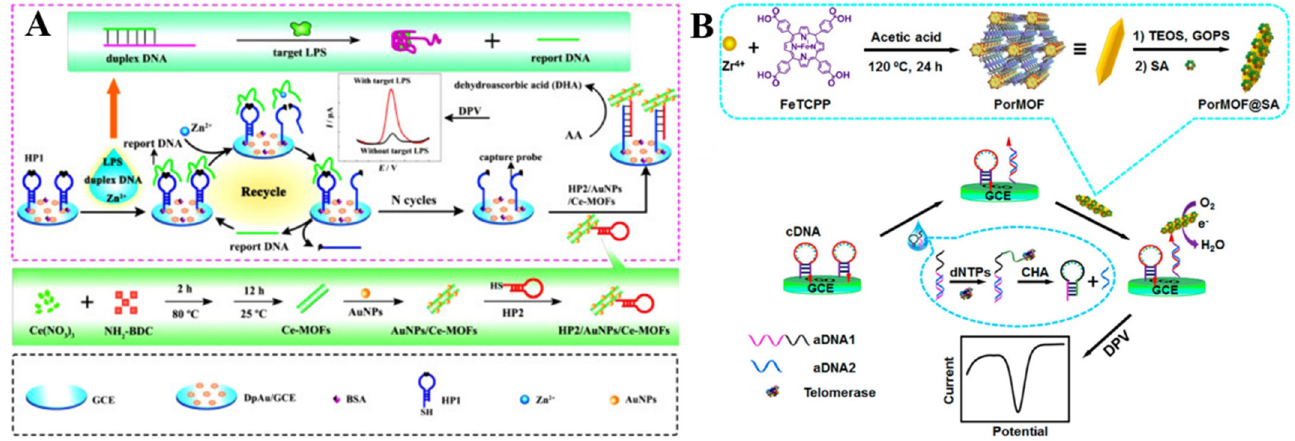
Figure 14. ( A ) Schematic illustration of the signal amplification strategy, the mechanism of LPS detection, and the preparation procedure of HP2/AuNPs/Ce − MOFs. Reprinted with permission from Ref. [252]. Copyright 2016, Elsevier. ( B ) Schematic illustration of the preparation of nanoscaled PorMOF and the electrochemical detection of telomerase activity via a telomerase-triggered conformation switch. Reprinted with permission from Ref. [255]. Copyright 2016, American Chemical Society.